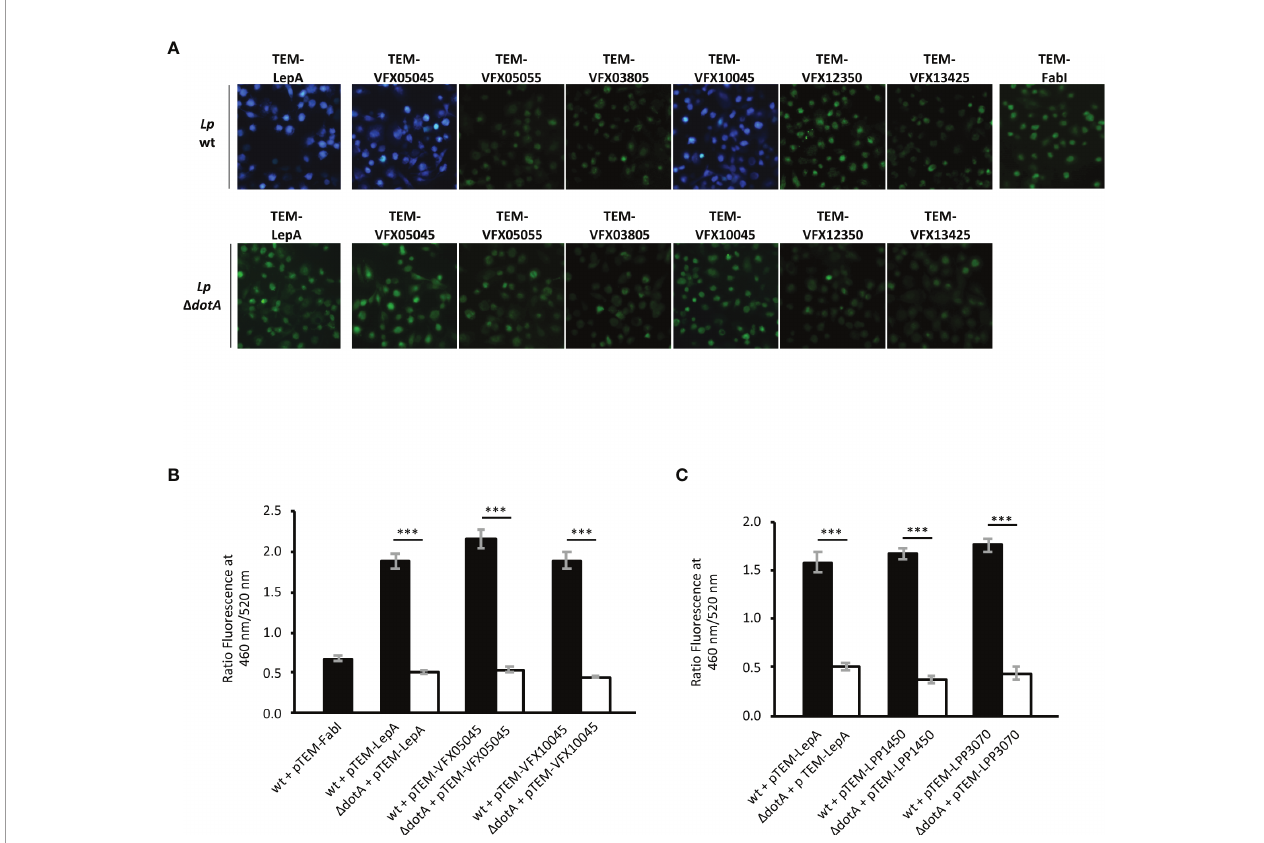
FIGURE 1 | New protein substrates of the Icm/Dot type 4 secretion system from strains L. pneumophila Pt/VFX2014 and L. pneumophila Paris. Translocation assays were performed in strains harboring plasmid encoded TEM-1 b -lactamase fusion proteins: FabI, non-translocated protein; LepA, translocated protein; and Icm/Dot candidate substrates VFX05045, VFX05055, VFX03805, VFX10045, VFX12350 and VFX13425. Plasmids encoding the fusion proteins were introduced both in an Icm/ Dot + background (wildtype strain L. pneumophila JR32 in A and B, or L. pneumophila Paris in C) or Icm/Dot - background (corresponding dotA derivatives). (A) Merged images of fl uorescence emission acquired at 460 nm (blue channel) and 520 nm (green channel). (B, C) Total fl uorescence obtained for each channel was quanti fi ed using FIJI software (see Materials and Methods) and translocation expressed as a ratio of blue/green fl uorescence (460/520 nm). Error bars represent the standard error of the mean of three independent biological repeats, each with at least 10 samples. Statistical analysis was made using Student ’ s t-test (***,